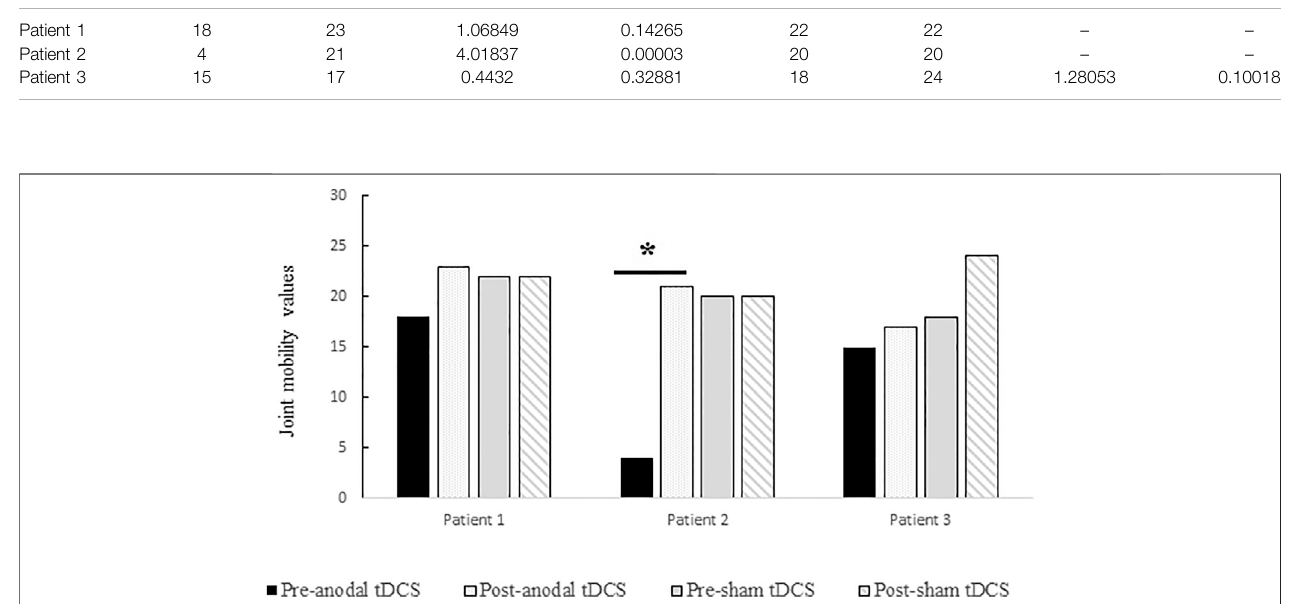
FIGURE 4 | Fugl-Meyer joint mobility (spasticity) values of the three patients before the intervention (day 1, pre-anodal or sham tDCS) and after the fi fth stimulation session (post-anodal or sham tDCS). Percentage differences were only signi fi cant between pre-anodal tDCS and post-anodal tDCS in patient 2 ( p < 0.001).